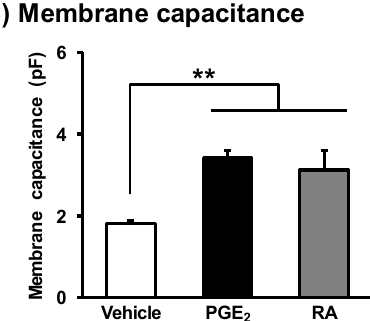
Figure 4. Generation of inward currents in NSC-34 cells. Undifferentiated NSC-34 cells were treated with a vehicle (EtOH), 30 µ M PGE 2 for 2 days, or 10 µ M RA for 7 days. ( A ) Representative inward current traces recorded by depolarization voltage pulses from –100 mV to +80 mV in 10 mV steps from a holding potential of –80 mV in each treatment group. ( B ) Upper graph shows current–voltage relationships recorded by voltage pulses in each treatment group. Lower graph shows the peak current densities of each treatment group. Each value represents the mean ± SD ( n = 18). * p < 0.05. ( C ) Graph shows membrane electrical capacitance in each treatment group. Each value represents the mean ± SD ( n = 18). ** p < 0.01.